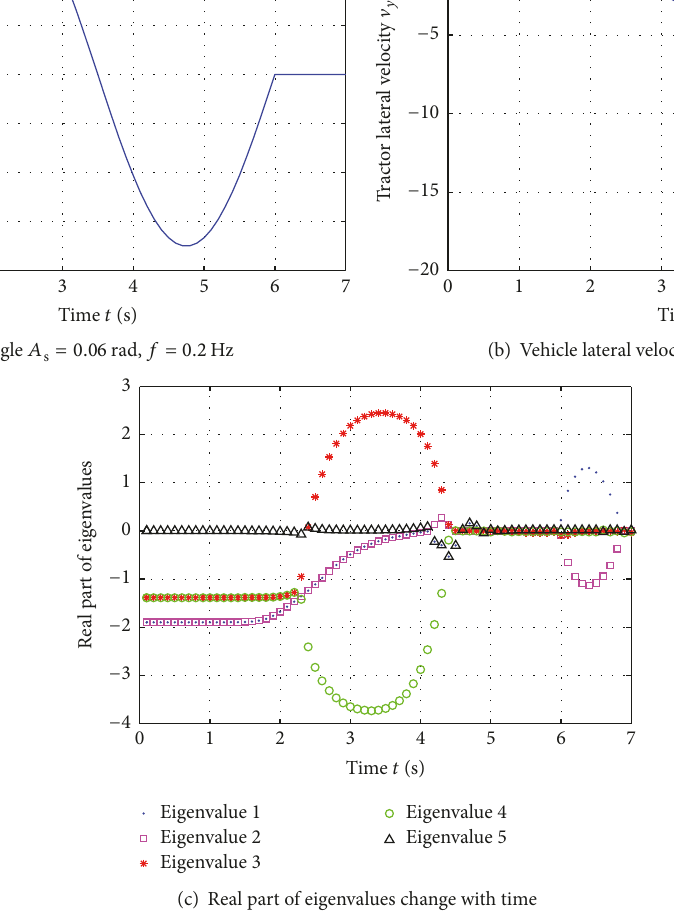
= 0.07 rad, 𝑓 = 0.2 Hz. s